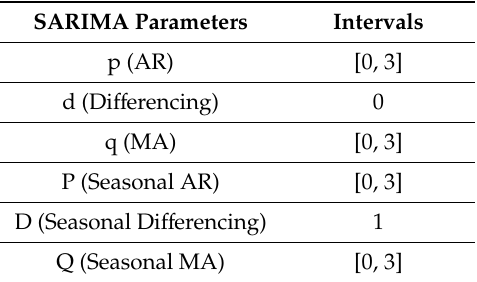
Table 1. Accuracy values from the execution of the predictive models. SARIMA Parameters